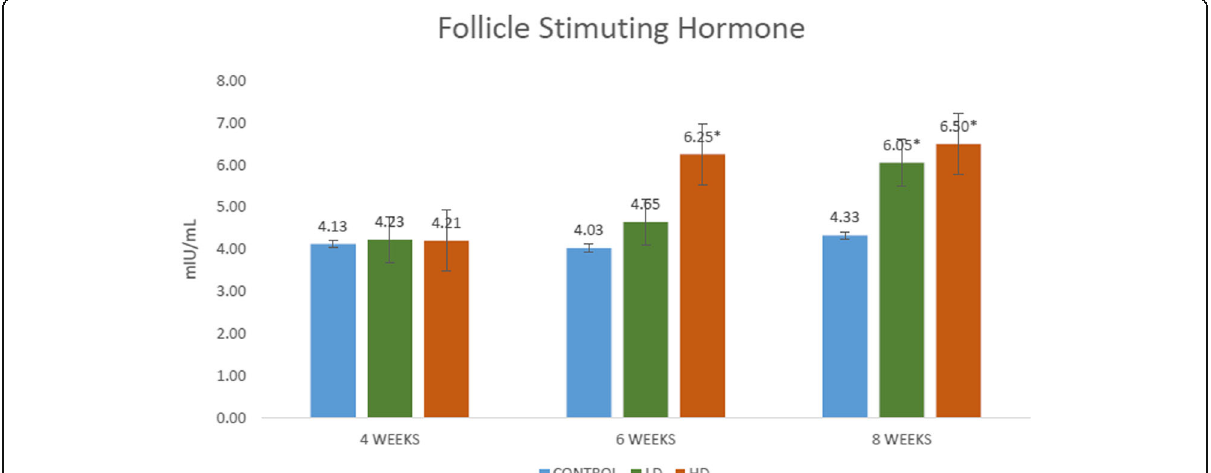
Fig. 3 Effect of aqueous root extract of Chrysophyllum albidium on serum concentration of follicle stimulating hormone (FSH) of the experimental rats. Bars represent Mean ± SEM. n = 5. *superscript shows Mean with significant ( P < 0.05) difference within each week